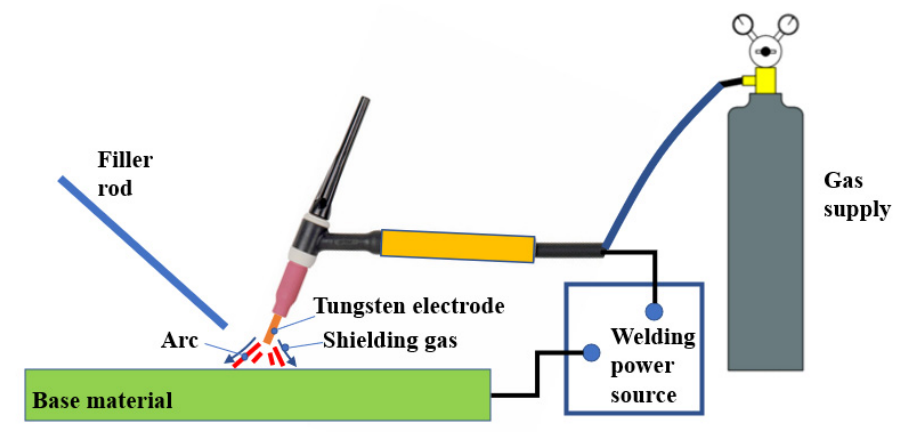
Figure 3. Mechanism of TIG welding process.